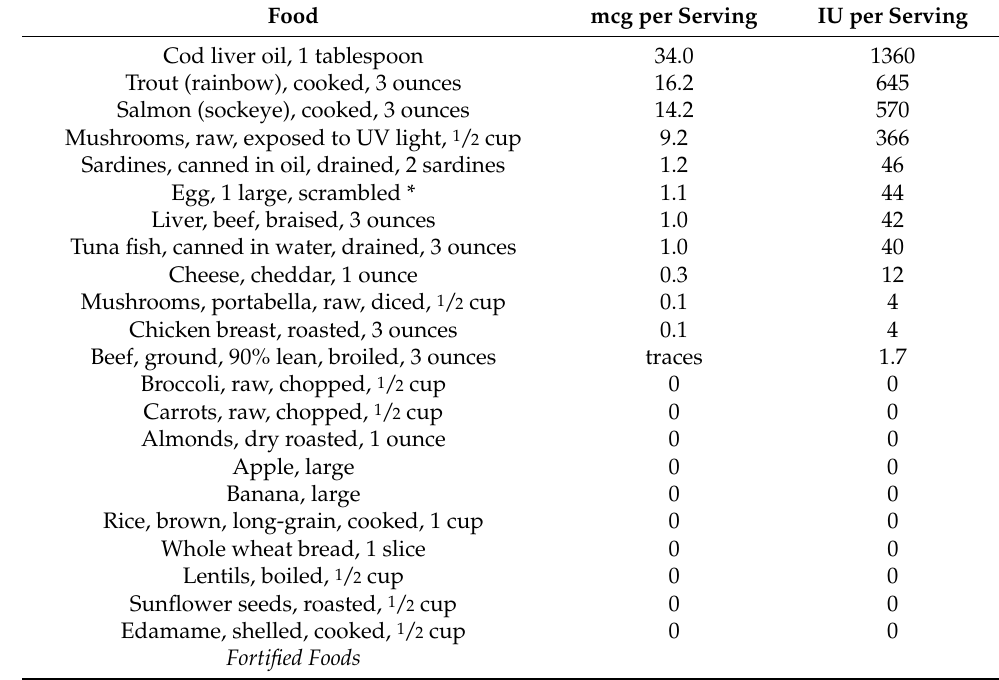
Table 1. Content of vitamin D in some foods.